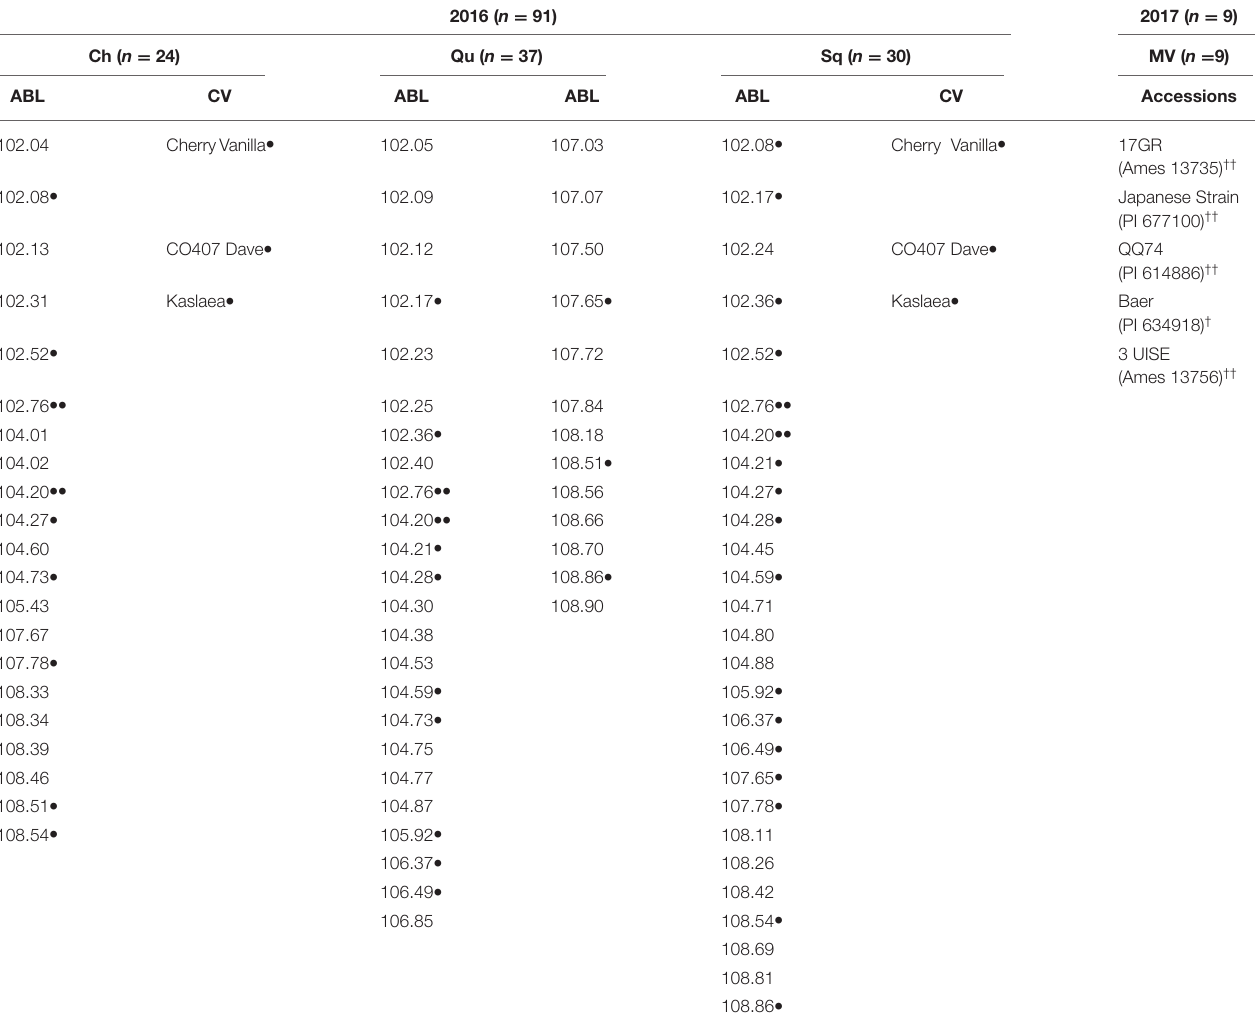
TABLE 3 | Summary of samples from both years, each location, and the identity of the advanced breeding lines (ABL) and control varieties